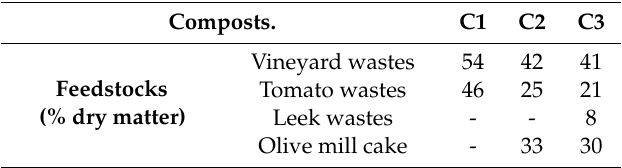
Table 1. Composition of composts in percentage of dry matter. Composts.